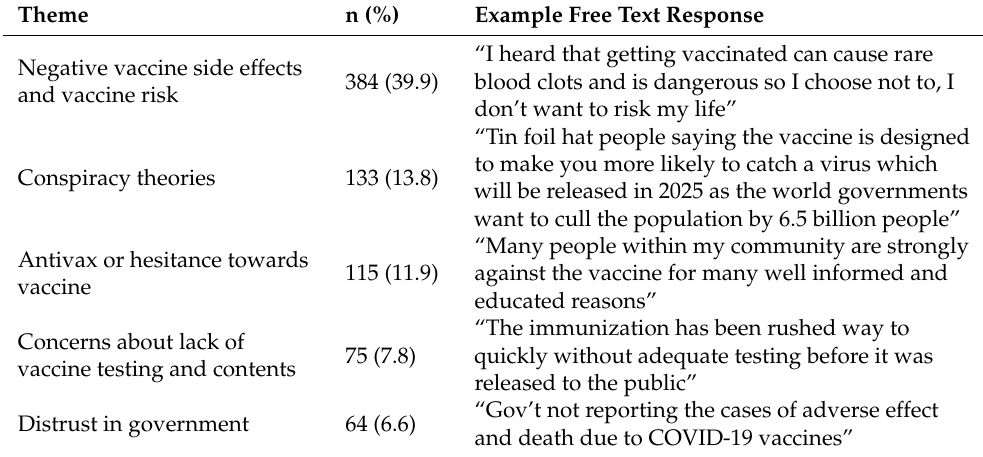
Table 9. Content discouraging COVID-19 vaccination that participants had witnessed, with frequency of the themes and example